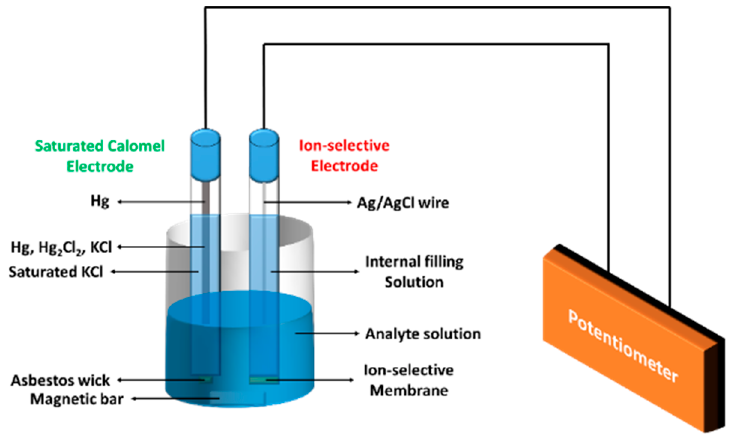
Figure 3. Schematic diagram of a conventional ion selective electrode. The electrochemical cell is made of Ag/AgCl|internal filling solution| polyvinyl chloride (PVC) membrane|analyte solution|Hg/Hg 2 Cl 2 , KCl (saturated). Adapted from [27].